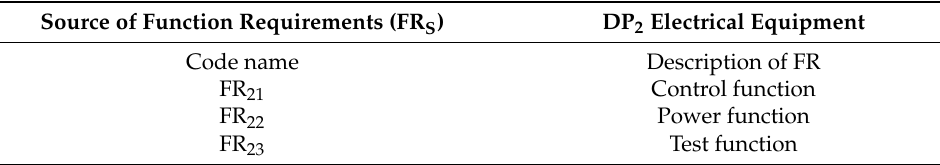
Table 8. List of terminal nodes for FR 21 , FR 22 , and FR 23 .